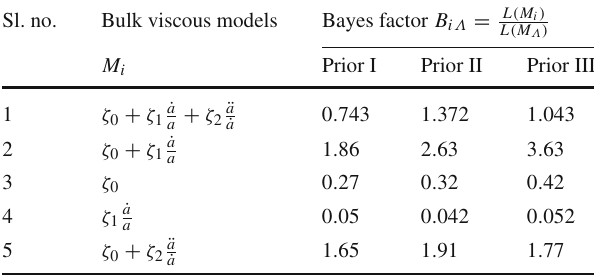
Table 2 Bayes factors with respect to Λ CDM model corresponding to three different priors Sl. no.